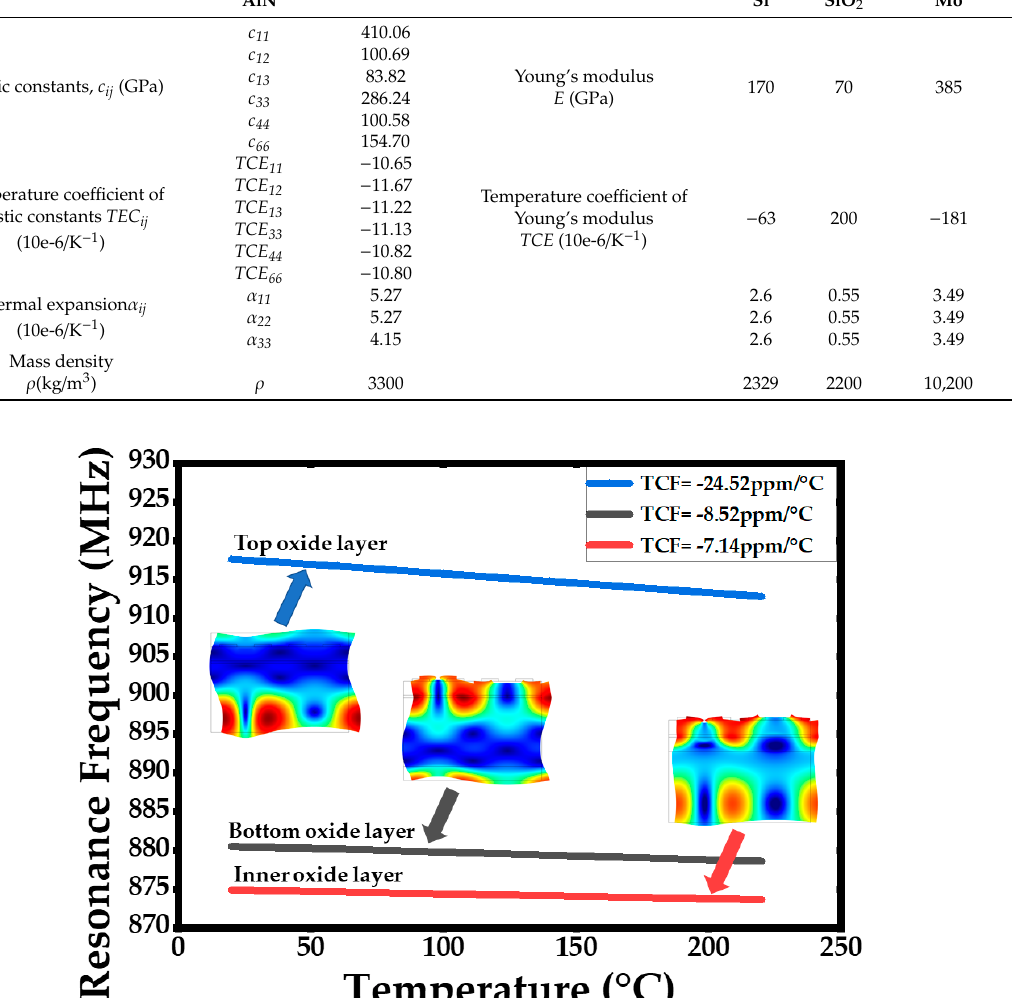
Figure 6. ( a ) The simulated acoustic wave mode shape (resulting displacement) with double temperature compensation layer, ( b ) temperature dependent of resonance frequency of acoustic wave resonator. From the above simulations, the optimized design of Lamb wave pressure sensor was put forward. Figure 7 demonstrate the 3D illustration of the Lamb wave pressure sensor and its cross- view. This Lamb wave pressure sensor carries an integrated vacuum cavity for directly absolute pressure sensing and has low temperature drifting. A stack of 0.02 μ m AlN/0.2 μ m Mo/1 μ m AlN/ 0.2 μ m Mo is deposited on an 8” CSOI wafer, which consists of a 5 μ m device Si layer and 1 μ m buried oxide (BOX) layer. The vacuum cavity used as a pressure reference cavity has a depth of 20 μ m. A 0.7 μ m SiO 2 layer was then deposited on the top as a temperature compensation and passivation layer. The device for experiment tests has 40 pairs of IDT electrodes and 60 Bragg reflectors. The IDTs were designed to be double-electrode-type in order to eliminate the wave reflection in IDTs, each electrode has a line width of 1.25 μ m, electrode space of 1.25 μ m and length